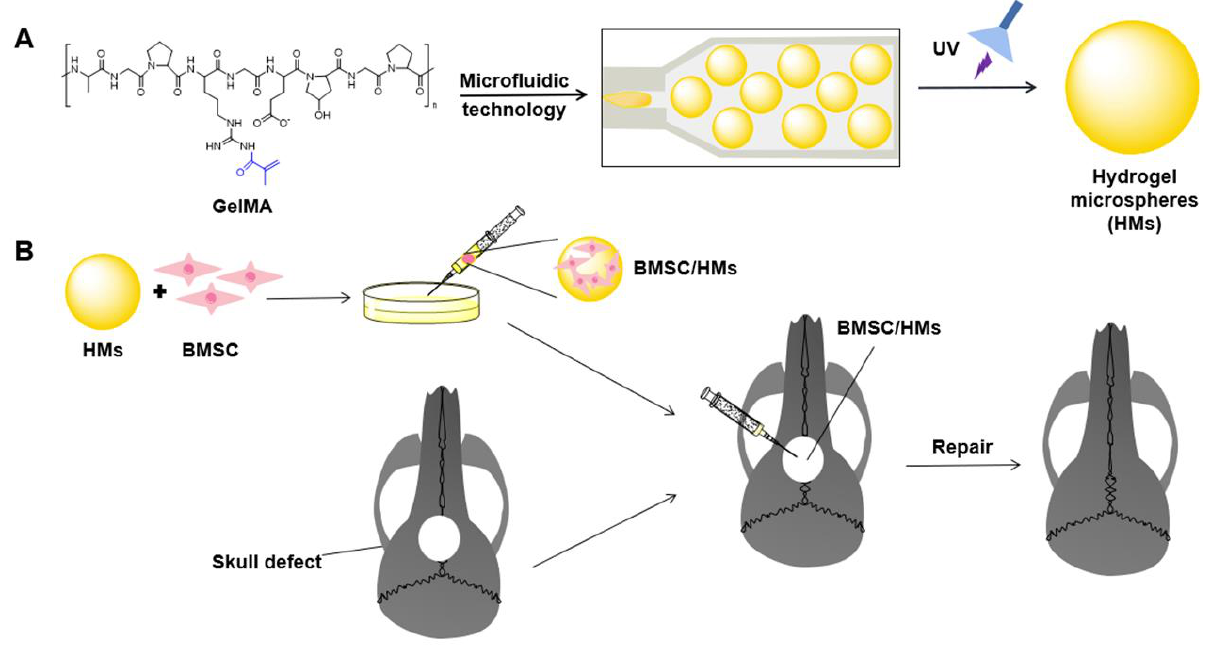
Figure 1. Schematic illustration of the preparation process of GelMA HMs and its treatment of skull defects. ( A ) HMs were fabricated by microfluidic technology with UV irradiation. ( B ) BMSCs were seeded on the HMs and then transplanted to the skull defects.